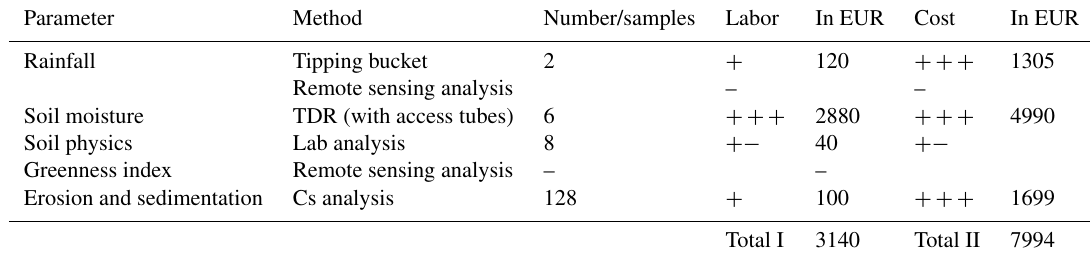
Table A5. Kenya case, scenario 2: to retry 1-year soil moisture measurement. Parameter